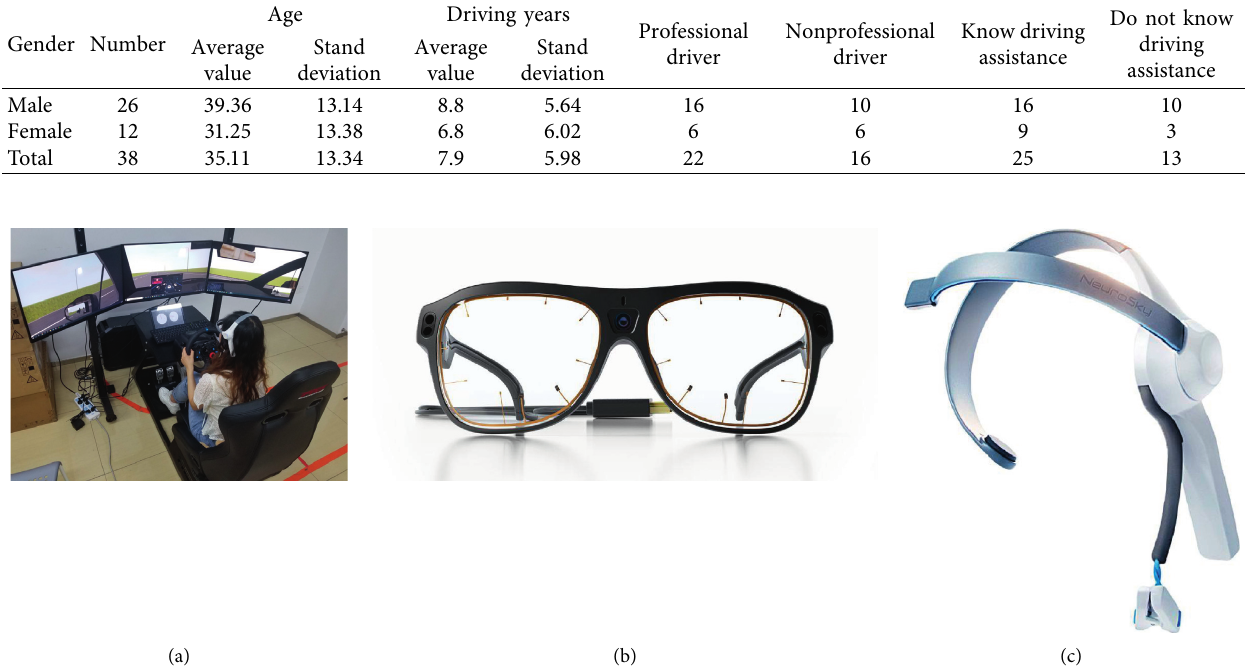
Table 1: Statistical information of subjects.